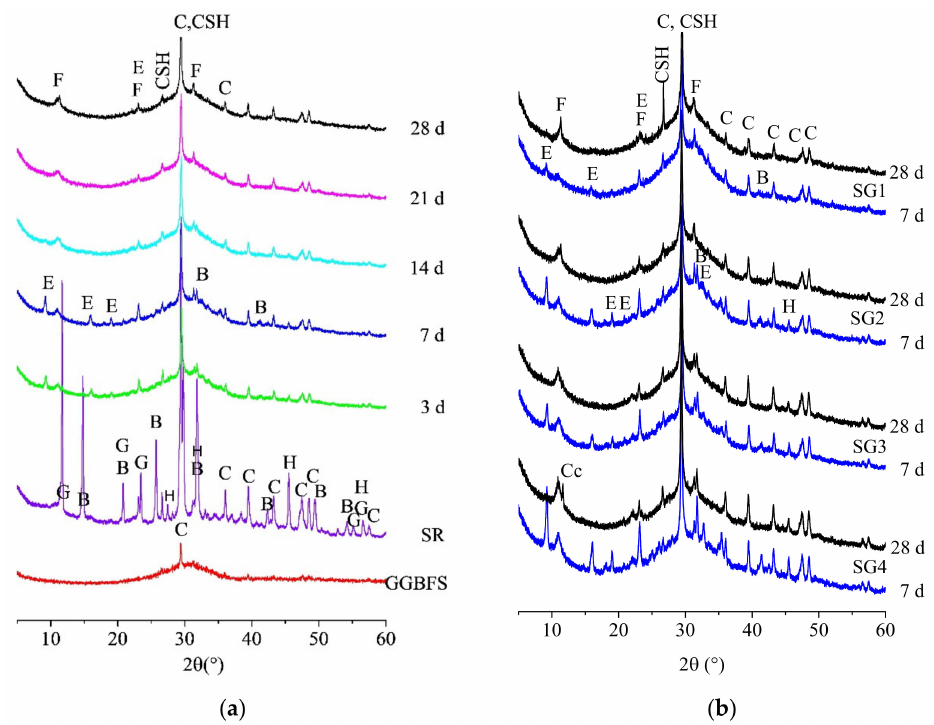
Figure 7. XRD patterns of ( a ) SR, GGBFS and SG2 at 3, 7, 14, 21 and 28 d; ( b ) SG1-SG4 at 7 and 28 d (B, Bassanite; CSH, Calcium Silicate Hydrates; C, Calcite; Cc-Calcium Chloride; E, Ettringite; F, Friedel’s Salt; G, Gypsum; H,